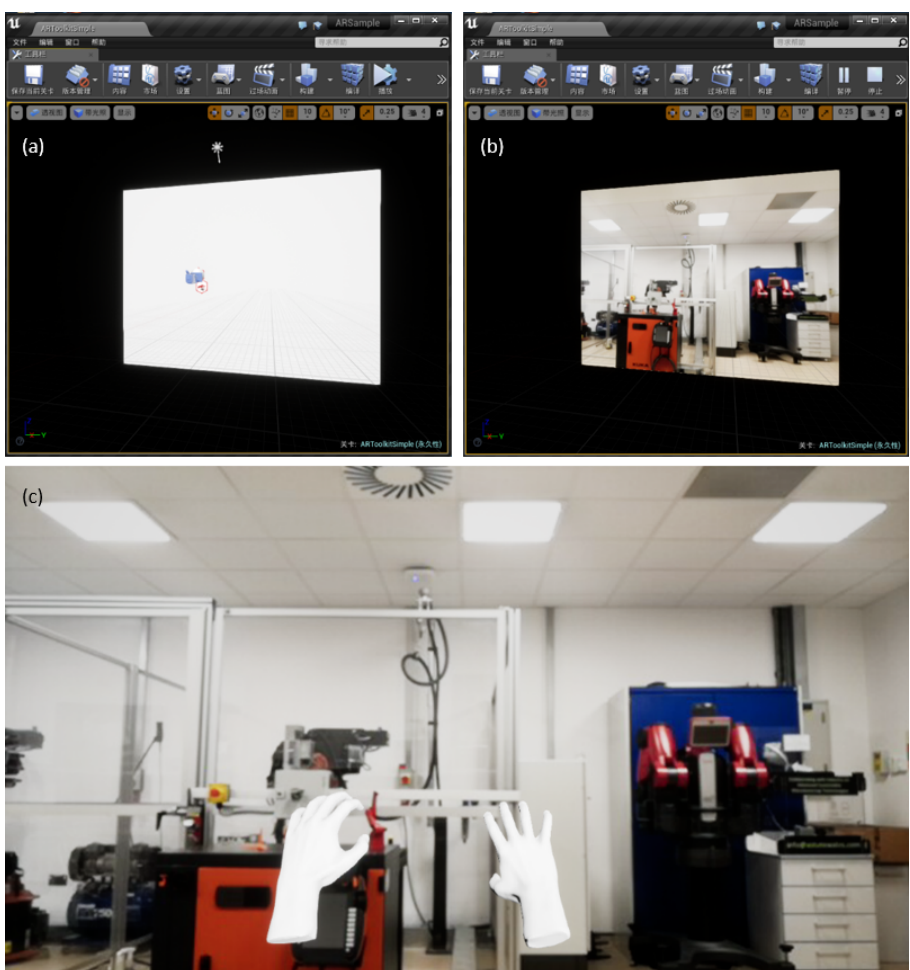
Figure 2. The Combination of LeapMotion Hands and the augmented reality (AR) environment: ( a ) Programme display without running; ( b ) Running programme display window without LeapMotion Hands; ( c ) Running programme display window with LeapMotion Hands in full screen